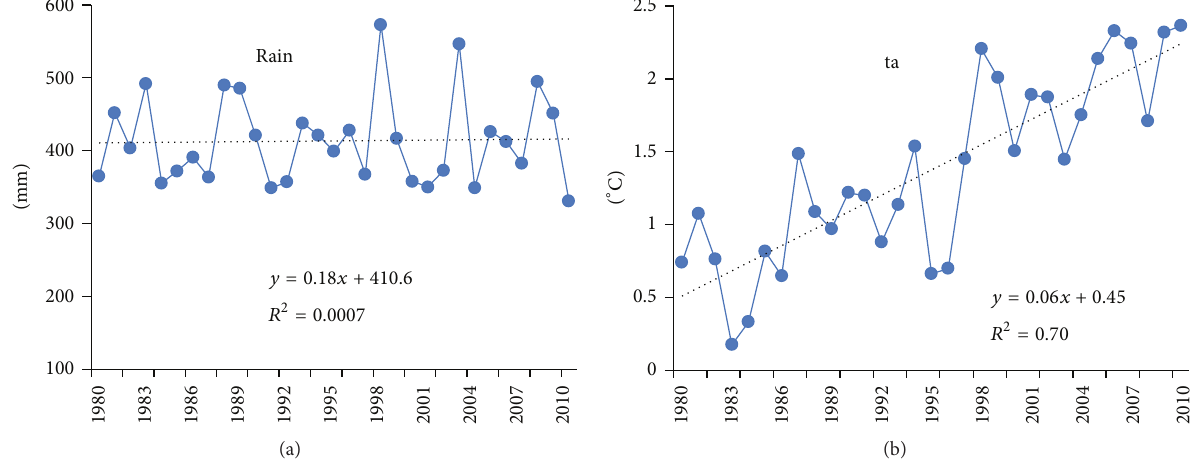
Figure 3: The change trend of precipitation and temperature at Qilan weather station during 1980–2010.